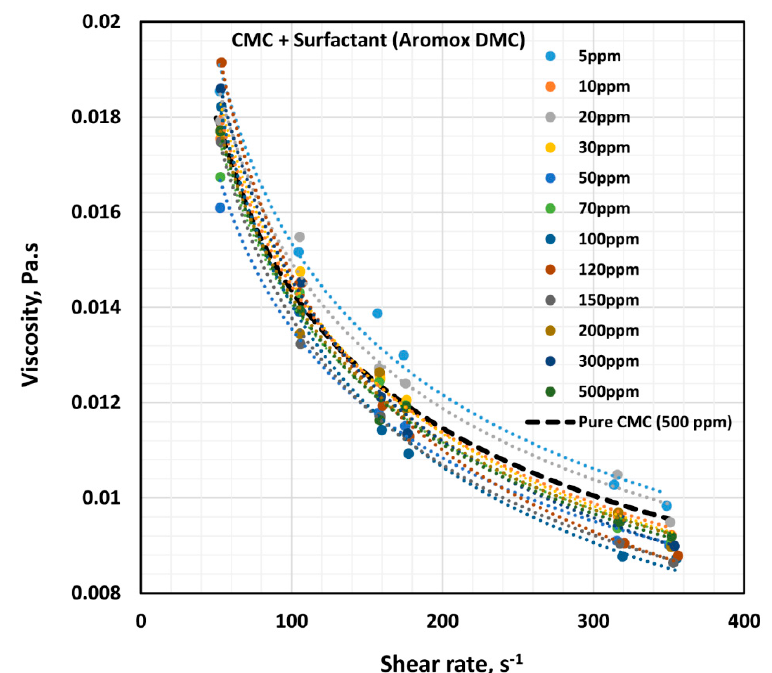
Figure 14. Effect of non-ionic surfactant (Aromox DMC) on the viscosity versus shear rate behavior of solutions of mixtures of the anionic polymer, CMC, and the non-ionic surfactant, Aromox DMC, at a fixed polymer concentration of 500 ppm.